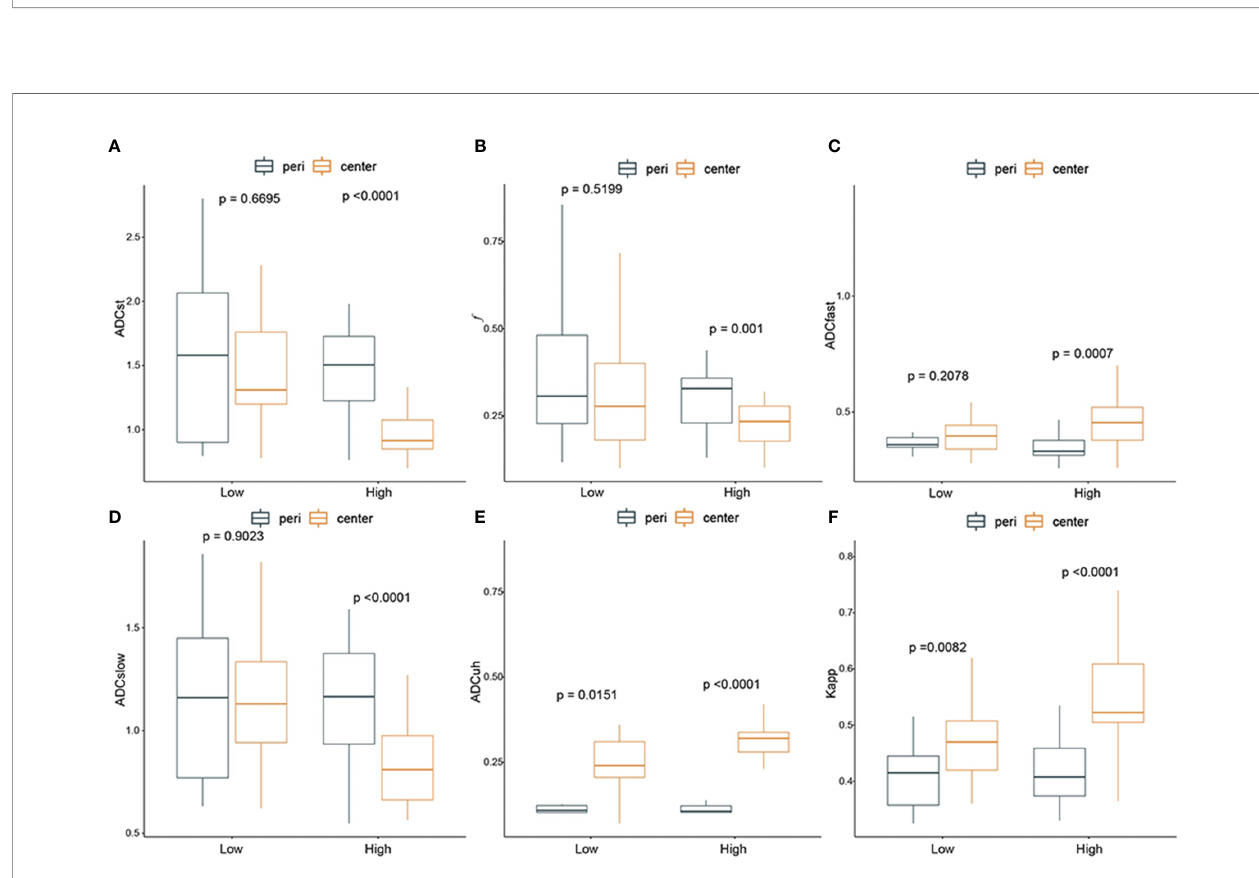
FIGURE 4 | The difference between diffusion weighted imaging (DWI) parameters at the center of the tumor and peritumor in low- and high-grade gliomas. From (A – F) : ADC st , f , ADC fast , ADC slow , ADC uh , K app . Black box: peritumoral region; yellow box: tumor center. P-value < 0.05 indicated statistical signi fi cance.